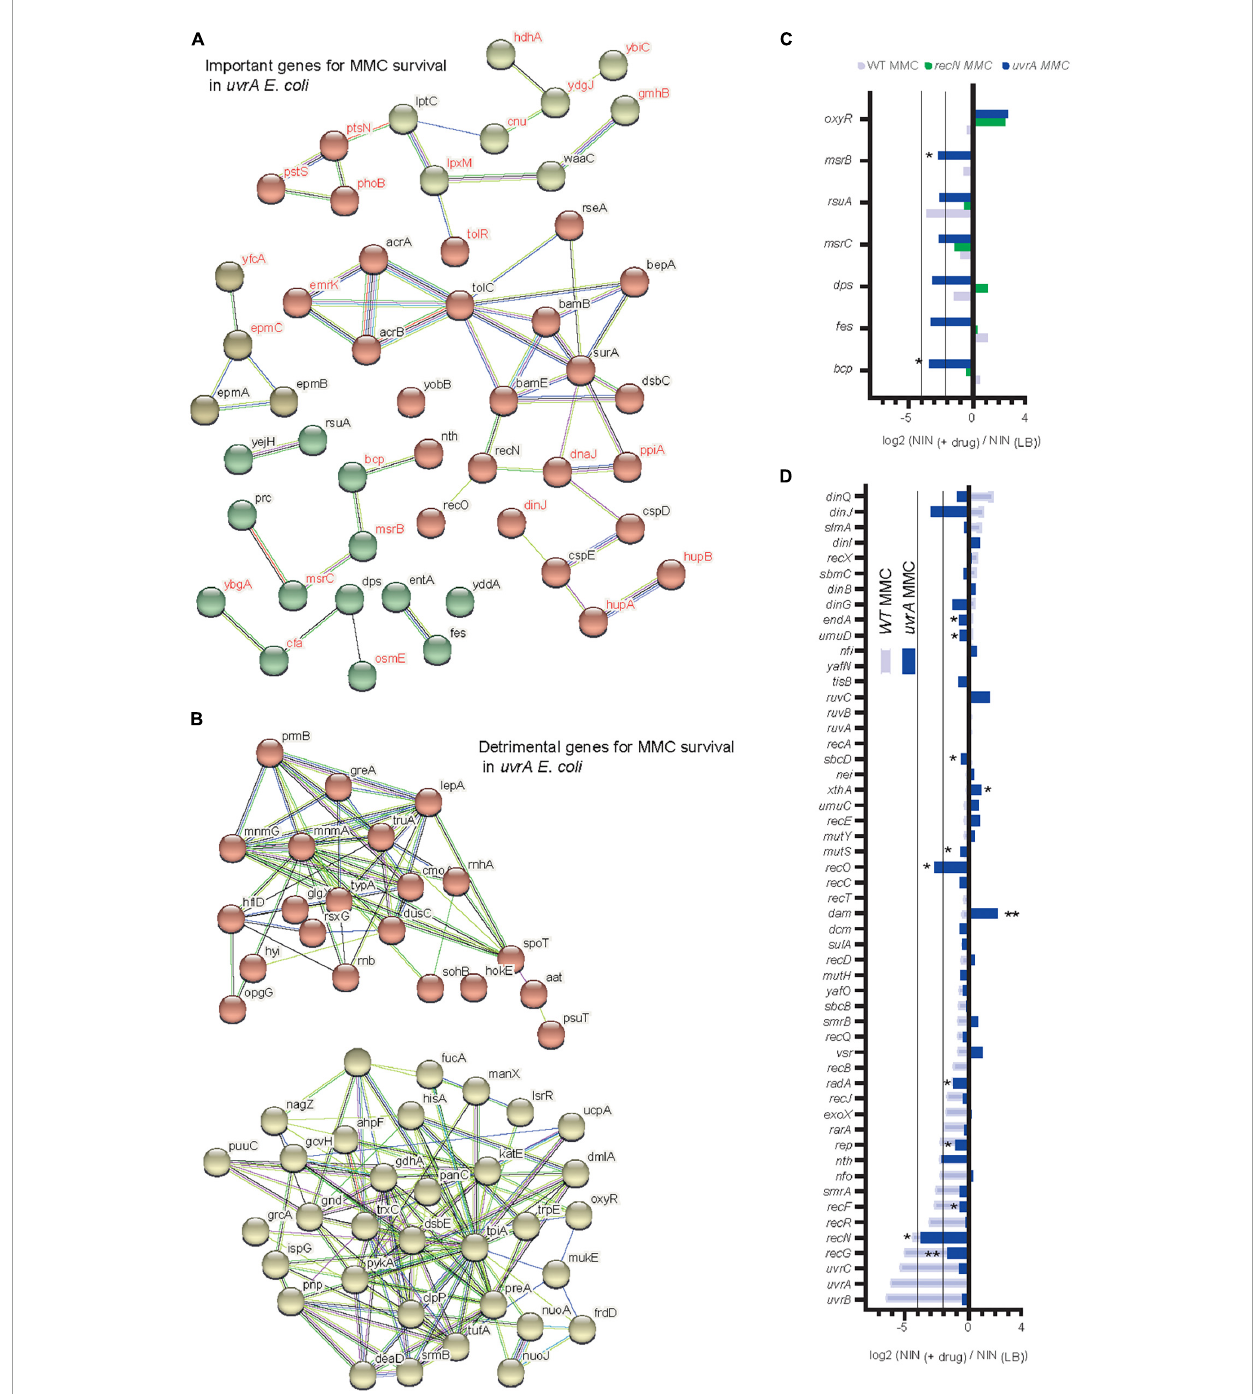
FIGURE6 Transposon-insertion sequencing (TIS) analysis of alternative pathways to NER for MMC tolerance. (A) Functional Kmeans clustering of important genes for MMC survival in the uvrA strain. (B) Functional Kmeans clustering of the counter selected genes for MMC survival in the uvrA strain. (C) TIS results in the presence of MMC for a subset of genes involved in oxidative stress tolerance in the WT, recN , and uvrA strains. Results are average of three replicates and analyzed with multiple paired t -test * < 0.1. (D) TIS results in the presence of MMC for the subset of E. coli DDR genes in the WT and uvrA strains. Results are average of three replicates and analyzed with multiple paired t -test * < 0.1, ** <